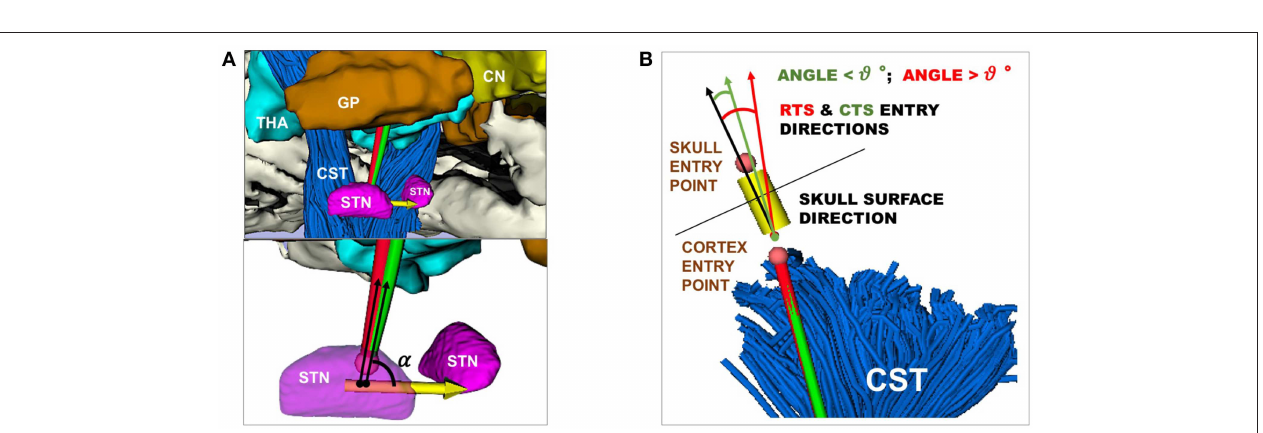
FIGURE 3 | (A) Representation of RT (red) and CT (green) entry angle, ( α ), into the STN, the illustrative scene of single-case example has been taken from 3D Slicer 4.7.0 (B) Representation of RT(red) and CT (green) in keeping a skull entry angle < θ ◦ , the illustrative scene of single-case example has been taken from 3D Slicer